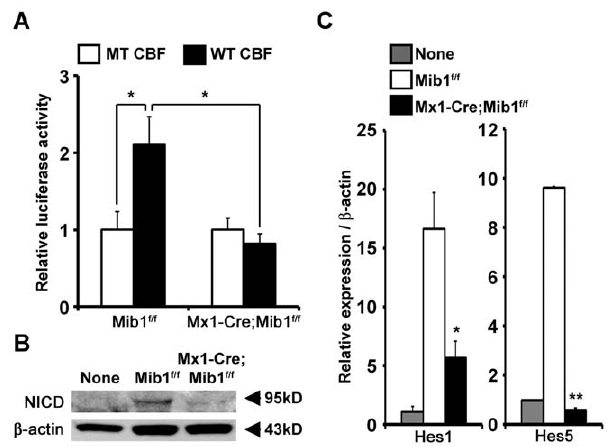
Figure 4. Preserved activation and proliferation of Notch-inactivated CD4 + T cells. A , Flow cytometry analysis for T cell activation markers, CD44 and CD69, in purified CD4 + T cells before (None) or 24 h after coculture with Mib1 f/f or Mx1-Cre;Mib1 f/f DCs. B , CFSE-labeled naive OT-II CD4 + T cells were cultured without ( None ) or with peptide-pretreated Mib1 f/f or Mx1-Cre;Mib1 f/f DCs, and the activated cells collected on days 1, 2, and 3, respectively, were stained for CD25 and CD4 and analyzed by flow cytometry. The numbers indicate the percentage of cells within the gates. A representative of three independent experiments is shown.